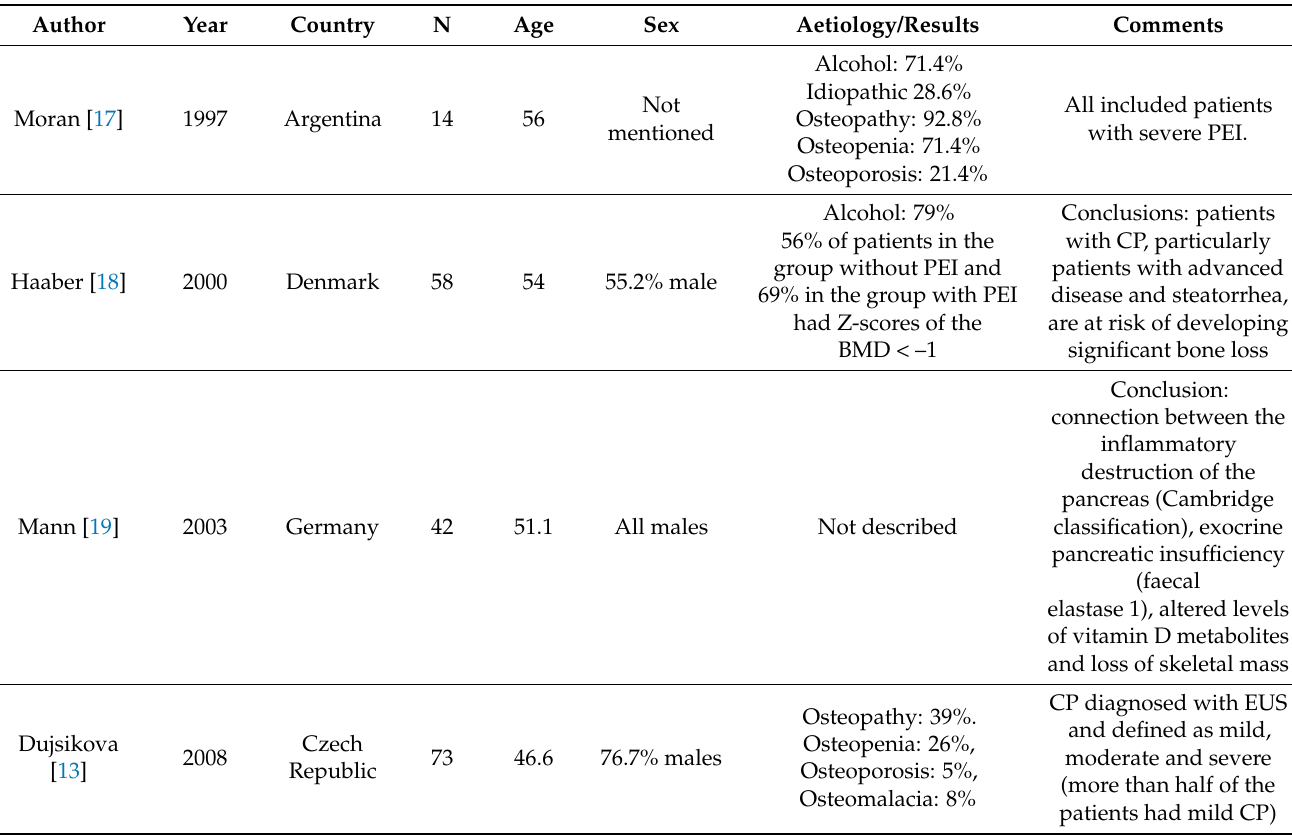
Table 4. Studies published on osteopathy in chronic